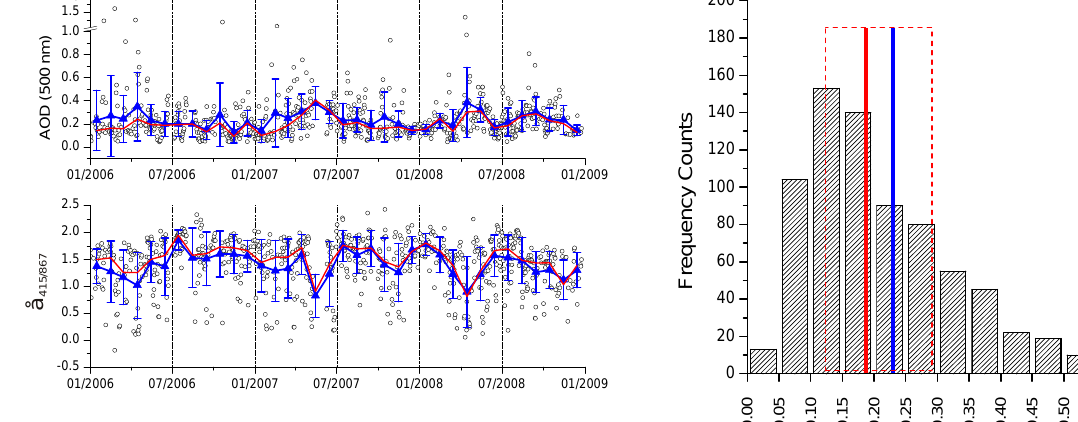
Fig. 1. Time series of daily AOD averages (upper panel) and ˚Angstr¨om coefficient (lower panel) over Athens, for the period Figure 1. Time series of daily AOD averages (upper panel) and Ångström coefficient 2006–2008. Triangles correspond to the monthly averages of the (lower panel) over Athens, for the period 2006-2008. Triangles correspond to the respective quantities and are accompanied by their standard devia- monthly averages of the respective quantities and are accompanied by their standard tion, while the red thin line represents the monthly medians. deviation, while the red thin line represents the monthly medians. Table 1. Basic statistics on the daily averaged AOD and the ˚Angstr¨om coefficient (˚a) over Athens, for the period 2006–2008. Average ± Stand. Dev.